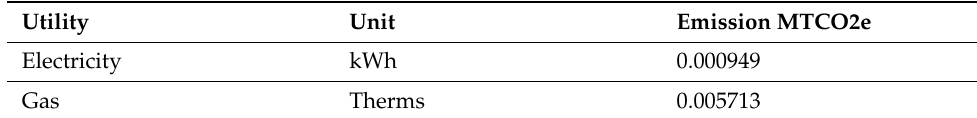
Table 7. Emission Factor of natural gas and electricity.